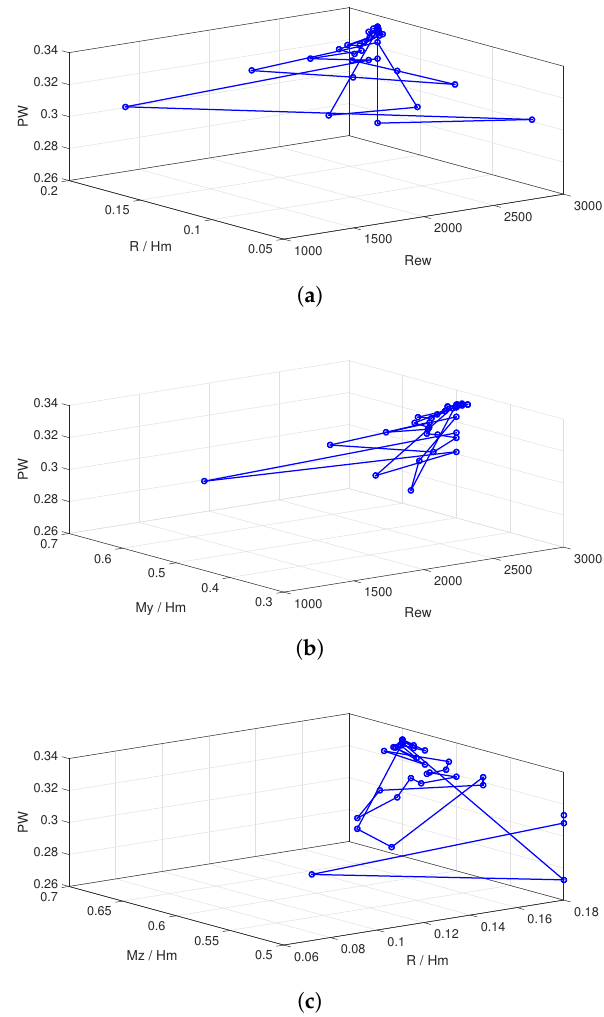
Figure 10. Search for the optimum set of parameters for the maximum power generation considering varying size-rotation ( a ), location-rotation ( b ) and location-size ( c